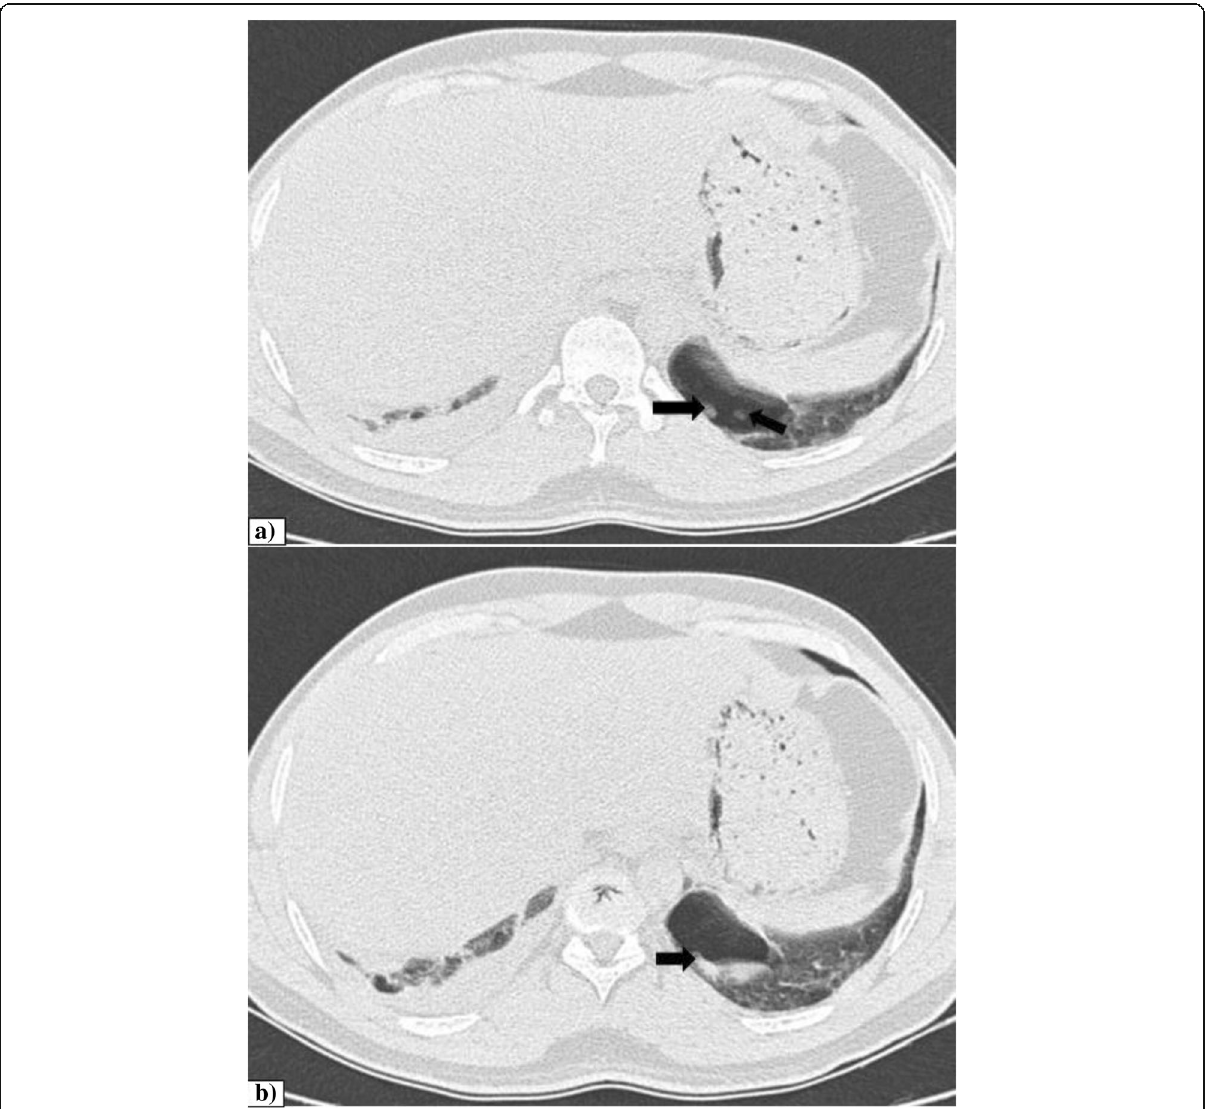
Fig. 4 Pulmonary cavity with clots. a , b Contiguous sections of axial CT thorax of a 35-years-old COVID pneumonia patient who presented with hemoptysis, showing thin wall cavity in the posterior basal segment of left lobe with soft tissue component of hemorrhagic density as indicated by the arrows. Right pleural effusion is also